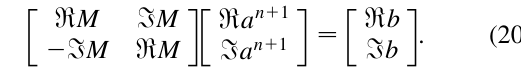
(cid:3) 4(cid:1) y (solid) 0